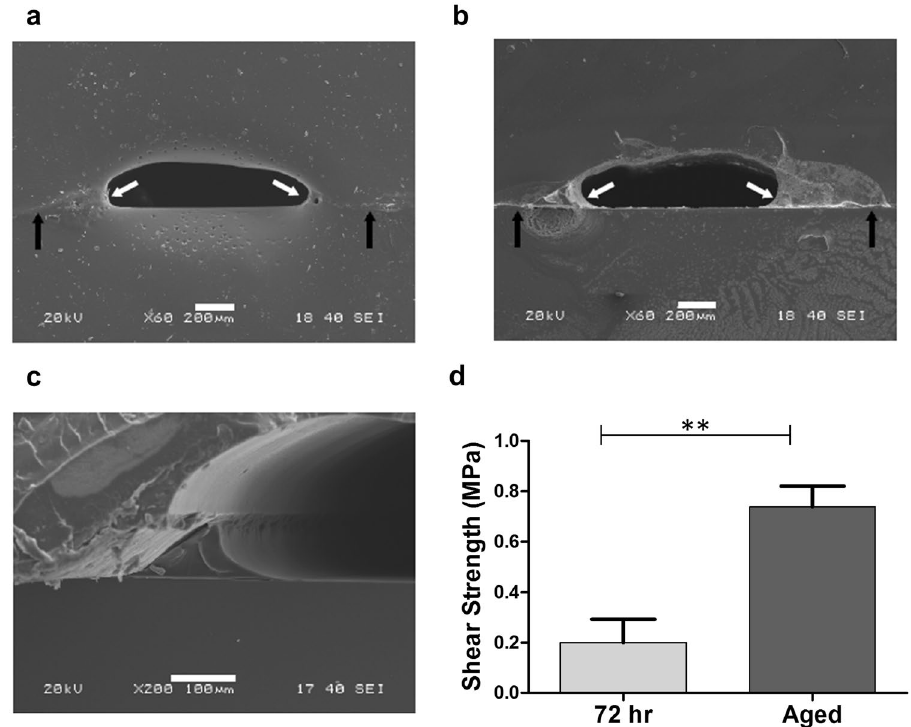
Figure 6. Characterisation of the adhesive bond. Transverse section PMMA chips bonded to PMMA ( a ) and glass ( b ) substrates analysed by scanning electron microscopy. A thin layer of adhesive can be observed at the interface between the two materials (black arrows). An accumulation of adhesive at the edges of the channel, resulting in an oval cross-section, can also be observed (white arrows). Scale bar: 200 μ m. ( c ) Detail of the accumulation of adhesive at the edges of the channel in a PMMA-Glass substrate. Scale bar: 100 μ m. ( d ) Bond shear strength for PMMA-to-PMMA adhesive bonding via capillarity-assisted adhesive delivery. Samples were allowed to cure for 72 hours or 2 months (aged) before tensile testing. ** p < 0.01 (Mean ± SD, n =